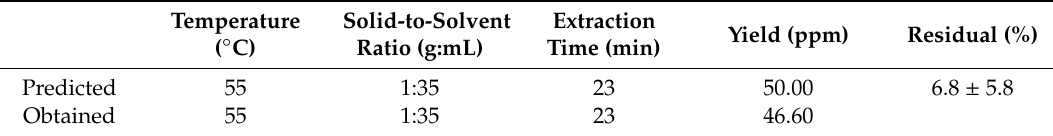
Figure 7. SEM image of leaves after UAE: (a) at 20 min; (b) at 40 min.